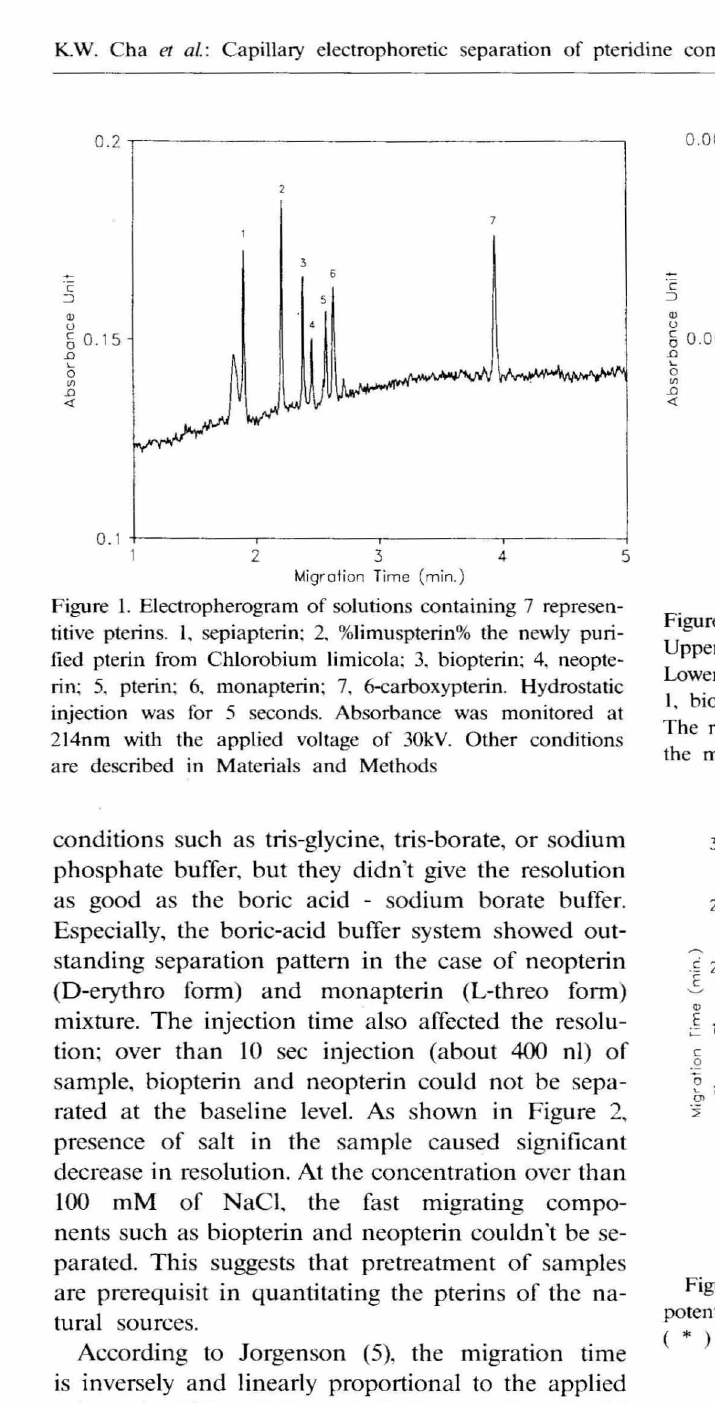
ments, solutions containing 20 to 100 uM of